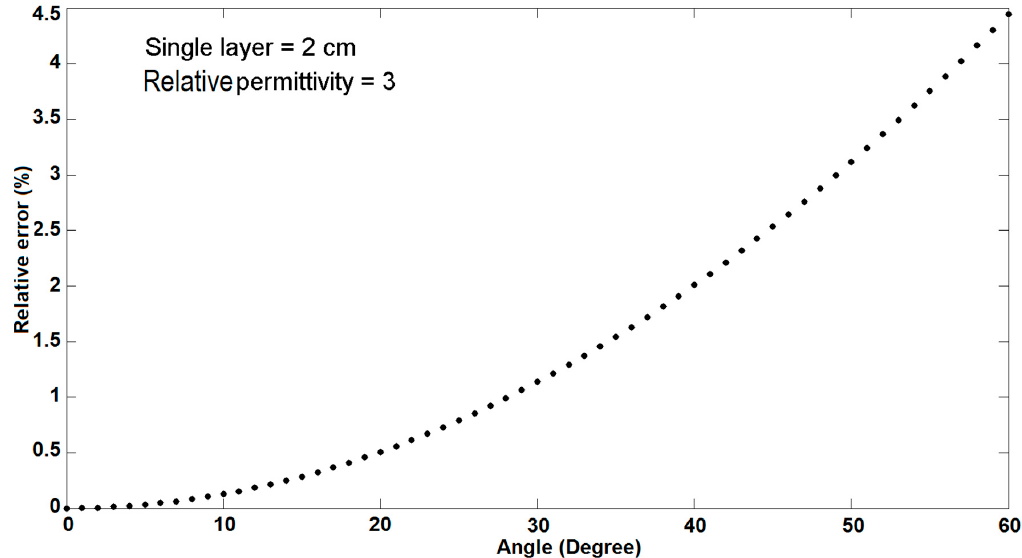
Figure 10. Relative error versus the angle between the two antennas for a 2 cm thin single-layer structure with relative permittivity equal to 3.